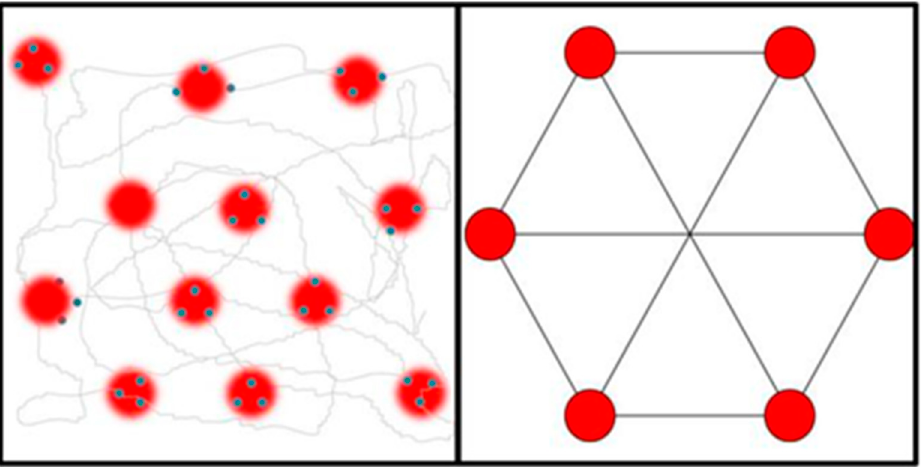
Figure 1. Schematic diagram of speed cell discharge.